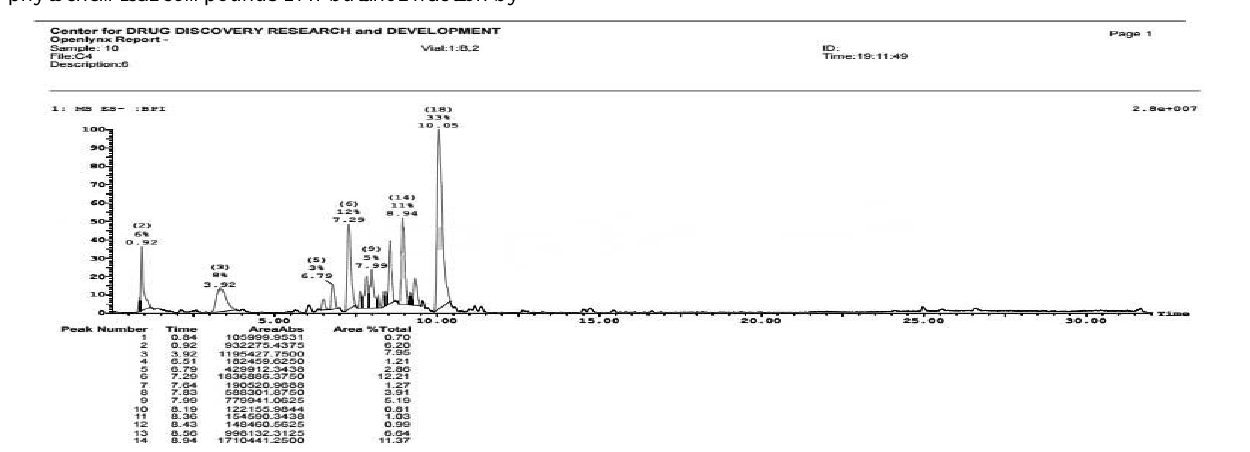
Figure 19. UPLC for n-butanol fraction.